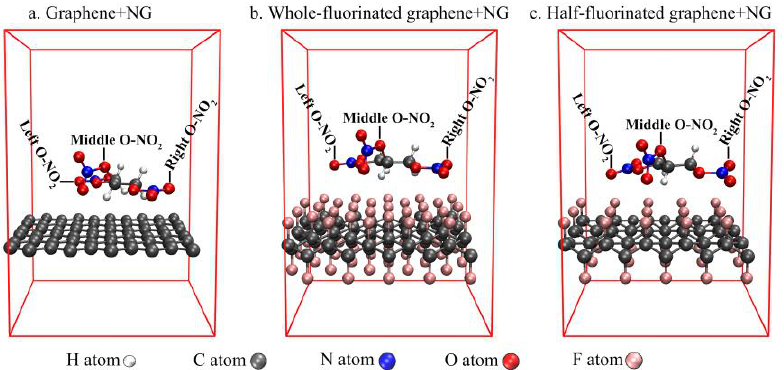
Figure 2. The structure of nitroglycerin (NG) on the surface of graphene, whole-fluorinated graphene and half-fluorinated graphene.